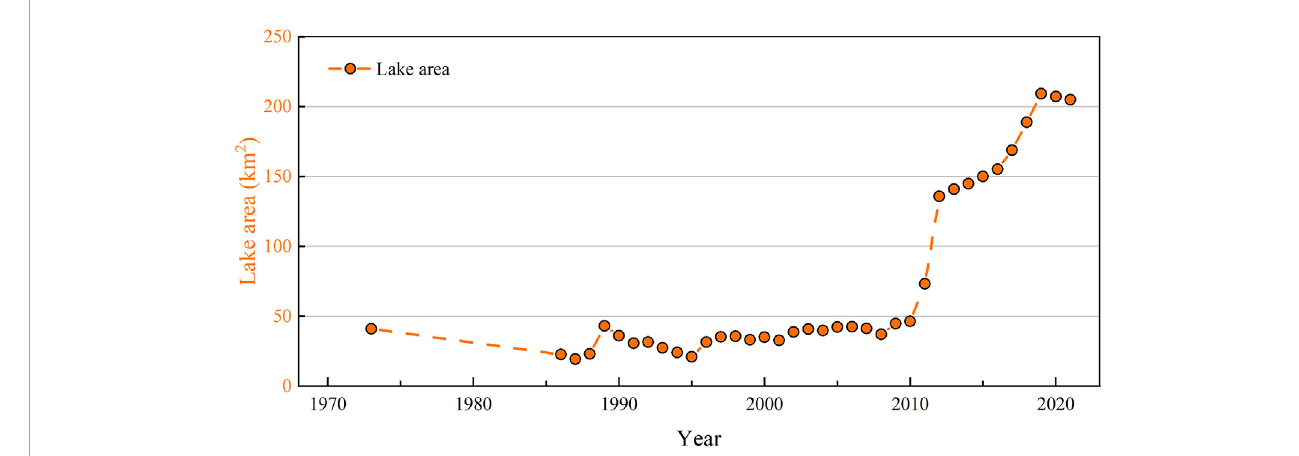
FIGURE 7 Changes in the Salt Lake area from 1973 to 2021.